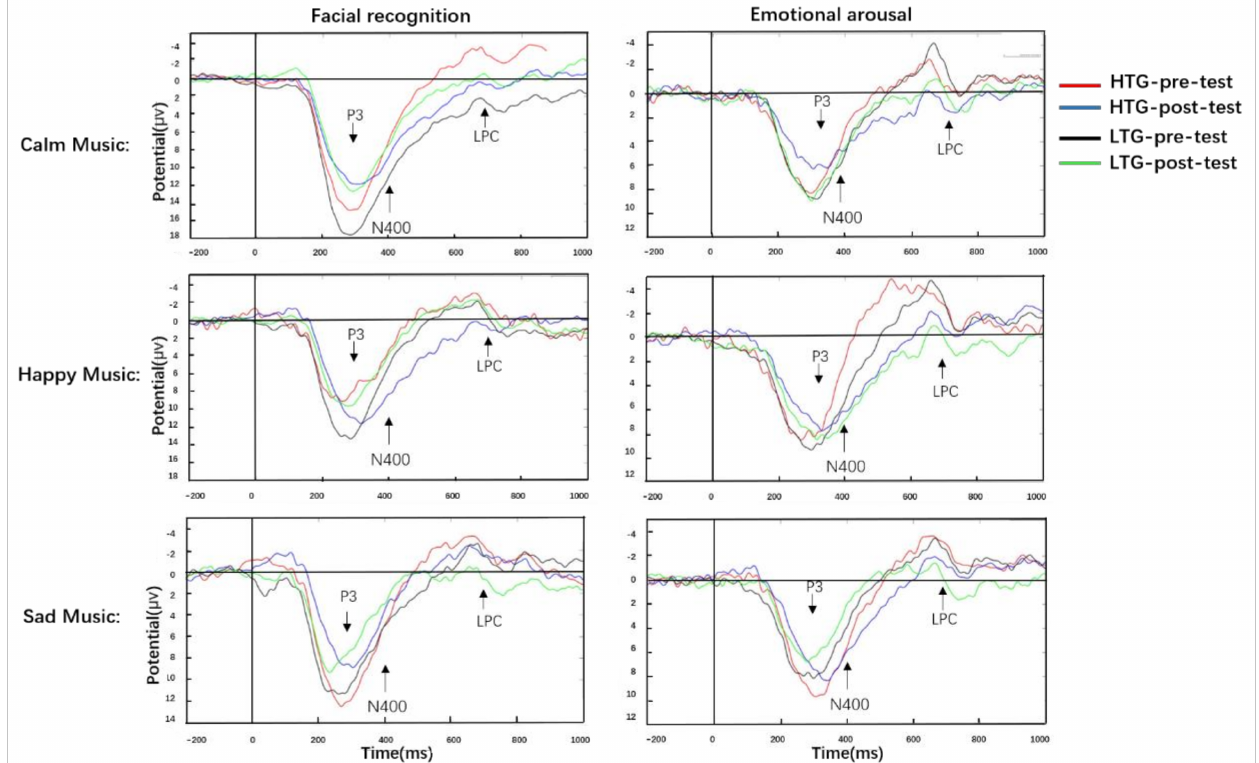
Figure 5. Grand average waveforms of P3 and late positive component (LPC) at site Fz in the facial recognition and emotional arousal task. HTG: high trait group; LTG: low trait